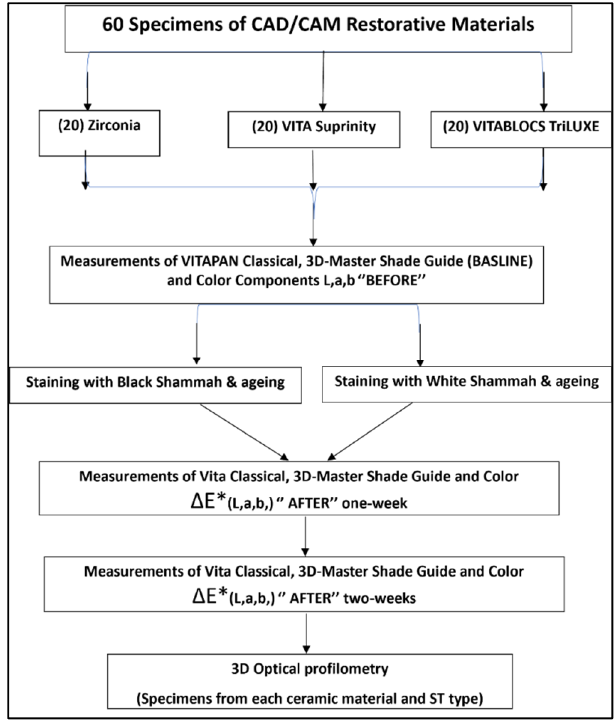
Figure 4. Flow chart demonstrating the study design, specimen distribution, and color measurement steps.